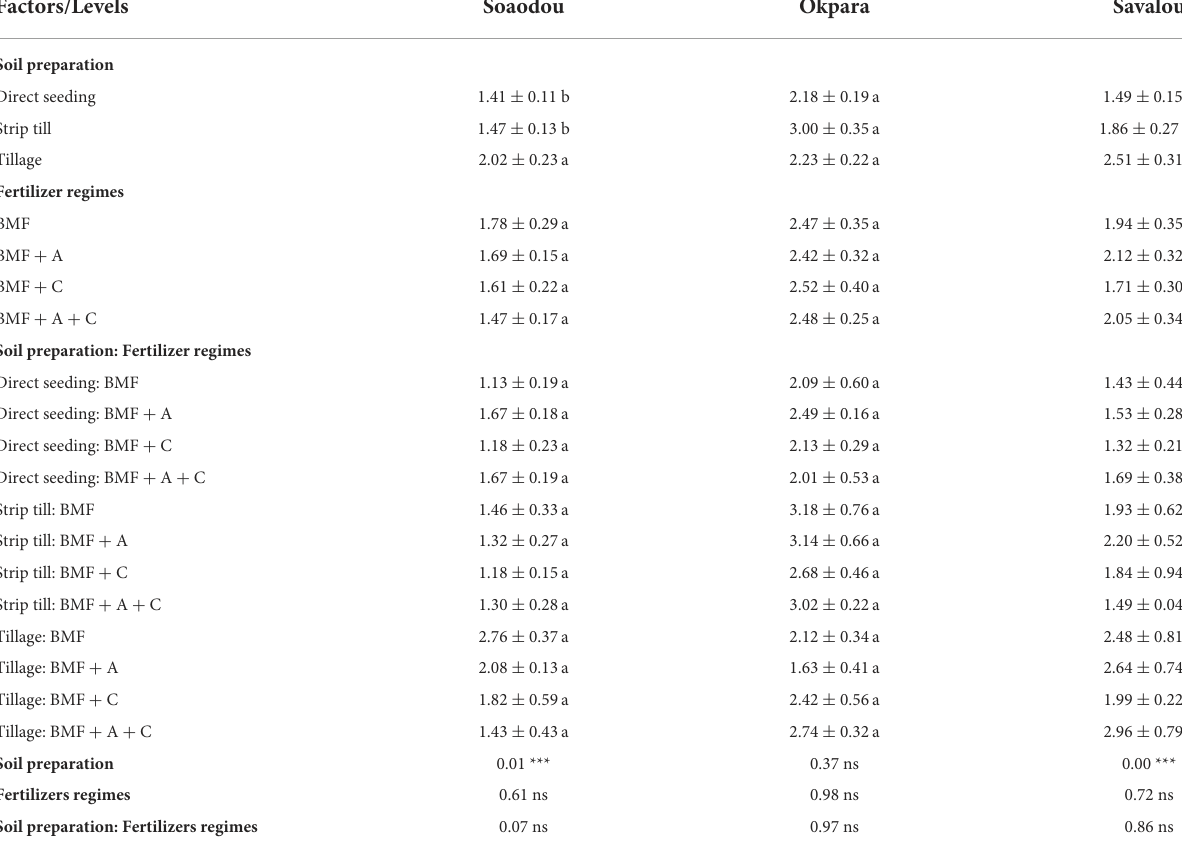
TABLE 4 Belowground biomass (g plant − 1 ) in cotton based cropping systems at 40 days after emergence (means are followed by standard error). Factors/Levels Soaodou